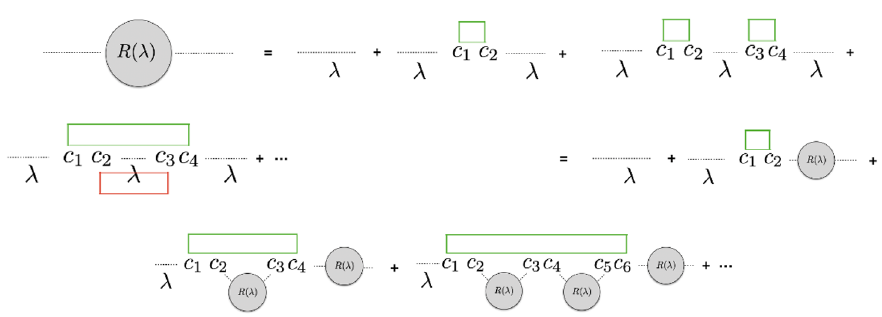
Figure 10 . Schwinger-Dyson equation for the resolvent R ( (cid:21) ) ij from summing planar